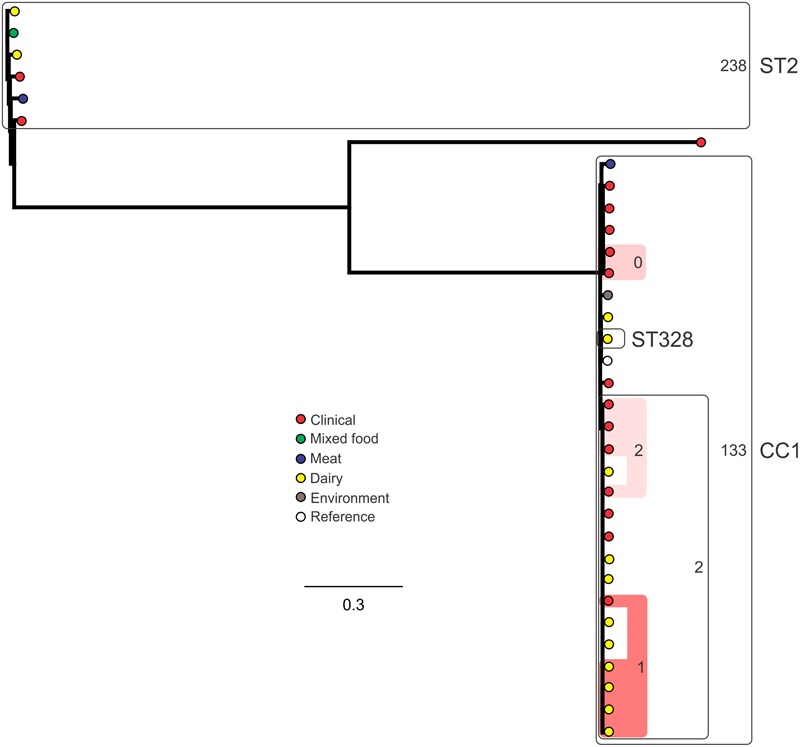
Phylogenetic analysis of serogroup IVB core genome SNPs. CCs and STs containing multiple isolates are indicated by labeled rounded rectangles (the CC or ST is labeled on the outside right, and the number of SNPs is indicated by the number on the inside right of the rectangle). Isolates linked by colored shading are epidemiologically linked, with the number indicating the highest number of SNPs when comparing isolates in that subset.